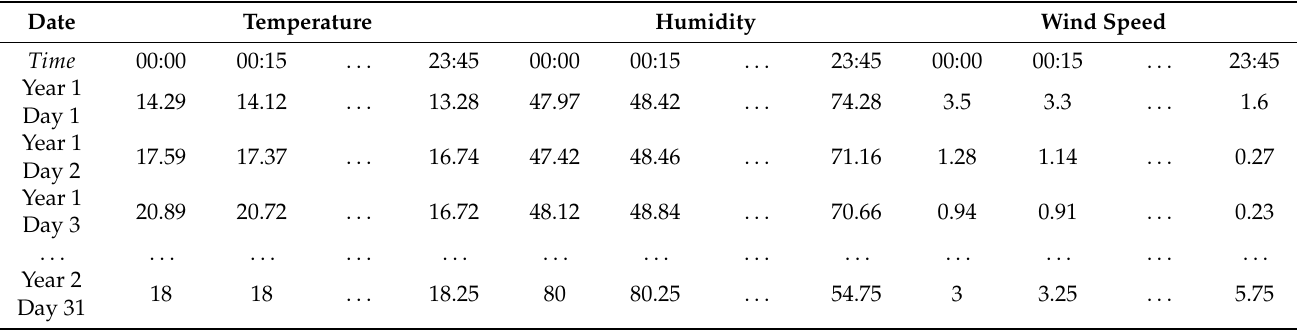
Table 1. Weather and Electricity Consumption